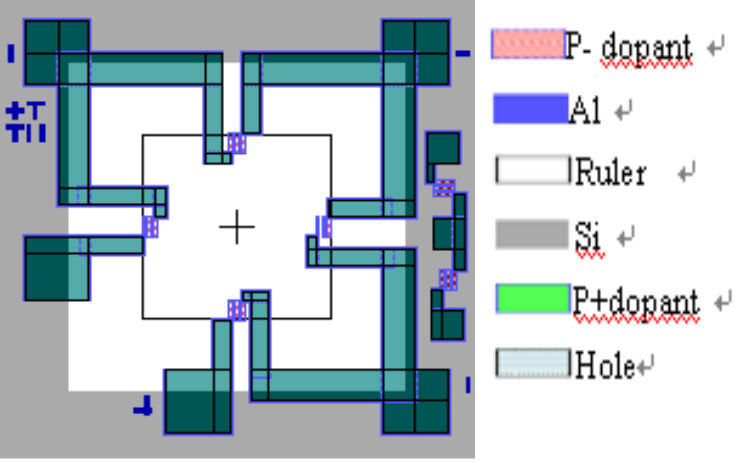
Figure 3. Schematic of a PZT pressure